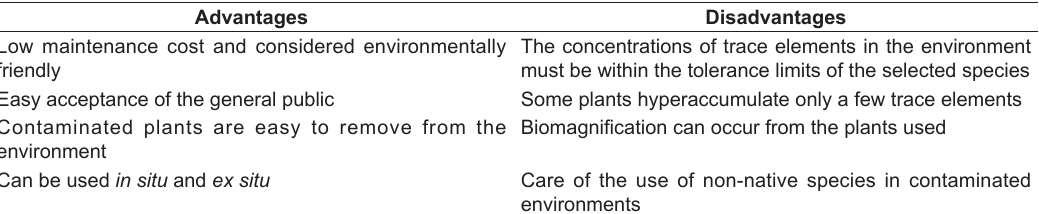
Table 1. Advantages and disadvantages of using of the phytoremediation approaches to remove trace elements in aquatic environments.